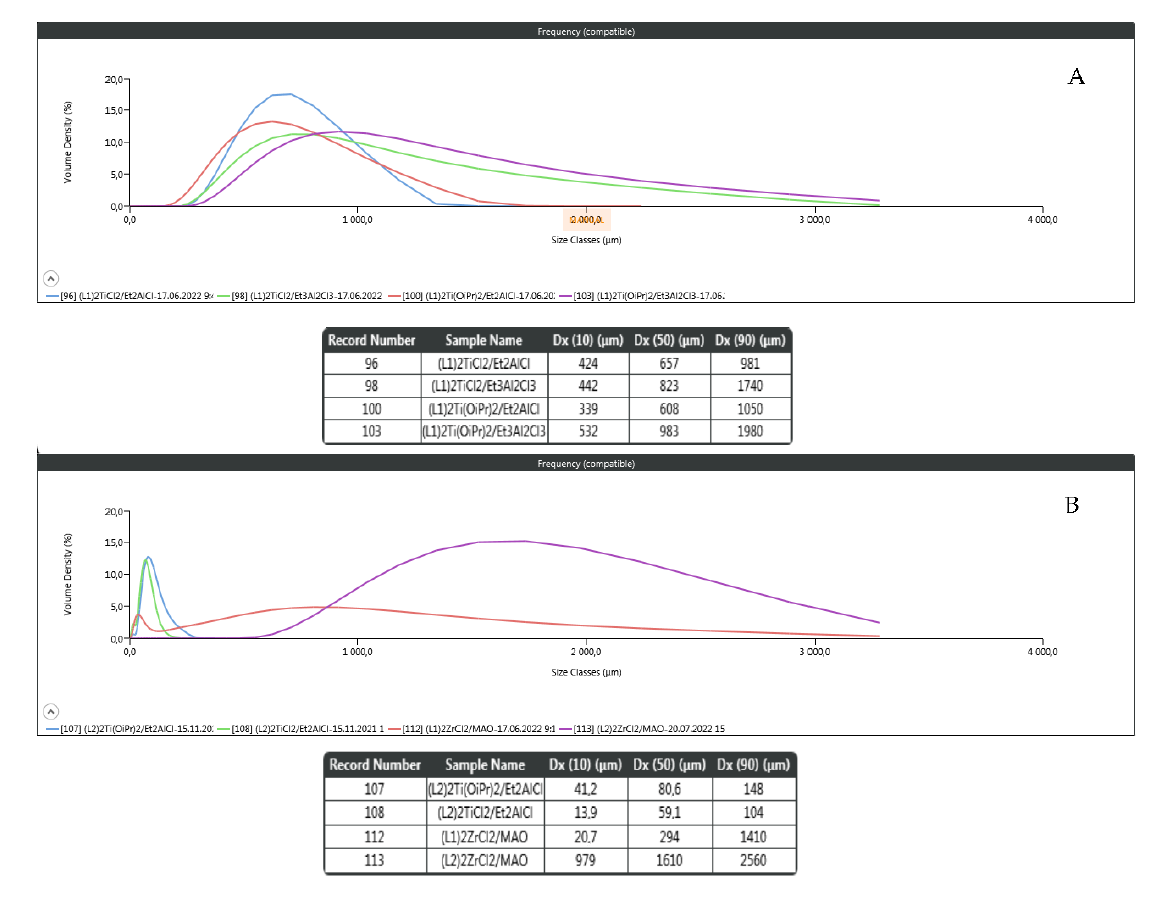
Figure 6. Particle size distribution of UHMWPE powders obtained in the Runs 1, 4, 7, 8 ( A ), 11, 14, 17, 21 and 25 ( B ) (Table 1).